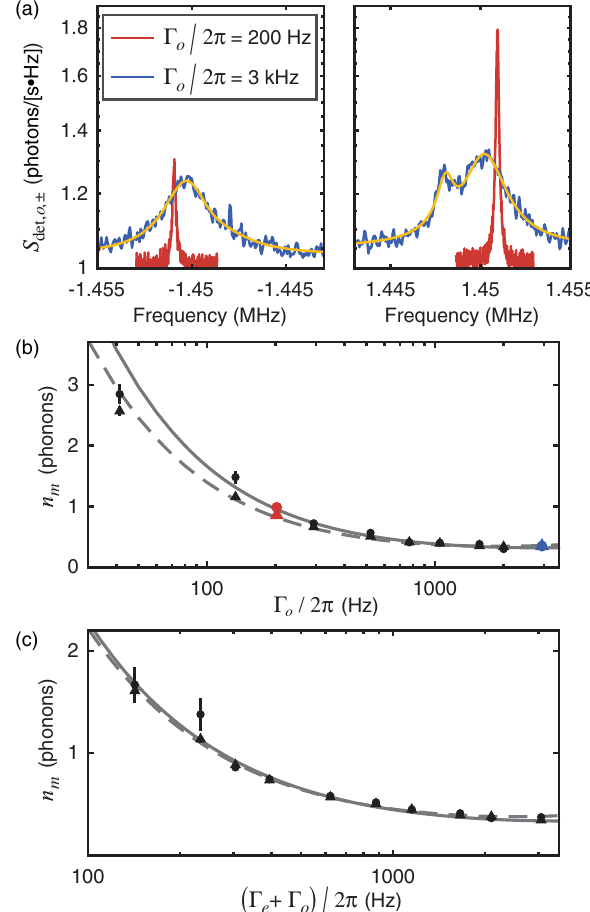
FIG. 9. Analysis of optomechanical spectra. (a) Two examples of optomechanical spectra normalized to shot noise at the optical heterodyne detector input. The left (right) panel displays the lower-sideband (upper-sideband) spectra. At high damping, we fit the spectra to the squared sum of two complex Lorentzian amplitudes (yellow line) to account for the 1.448 MHz mode of the silicon substrate. (b) Comparing two methods of inferring membrane mode occupancy n from purely optomechanical m damping sweep, with corresponding fits. Circles and solid line [also shown in Fig. 2(a)] are obtained using sideband asymmetry thermometry, while triangles and dashed line are obtained from the upper-sideband spectra S and optical measurement chain det ;o; þ . Red and blue data points correspond to the spectra efficiency ξ o shown in (a). (c) Comparing the two methods of inferring n for m optomechanical damping sweep at fixed electromechanical damp- ing [sideband asymmetry data and fit also shown in Fig. 2(b)]. All error bars represent one standard